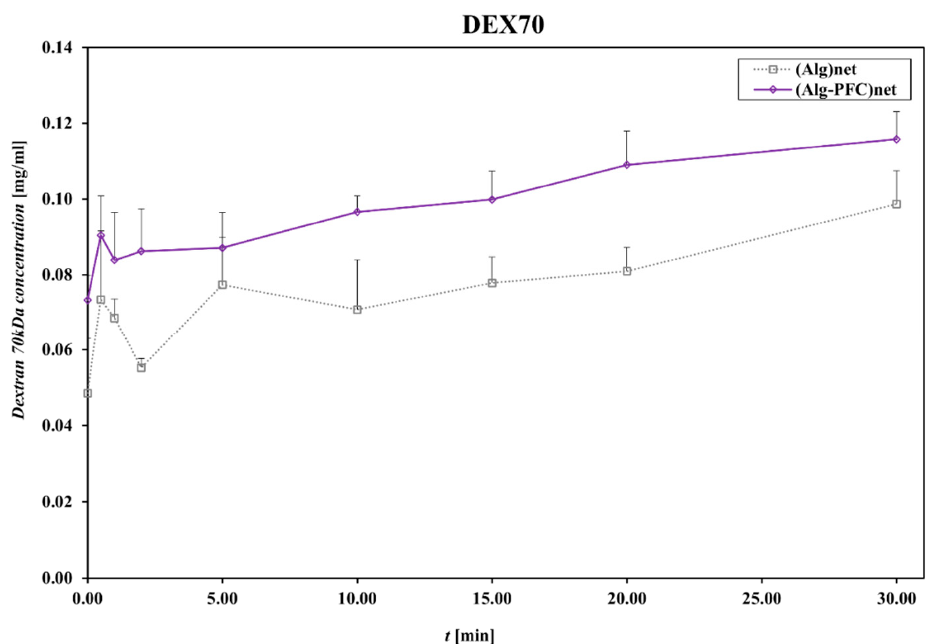
Figure 5. Dextran70 concentration in the function of time during permeation through the membrane. Key to symbols: (ALG-PFC) net —alginate–perfluorooctyl cross-linked; (ALG) net —alginate cross-linked. The values are presented as mean ± SD ( n = 6).